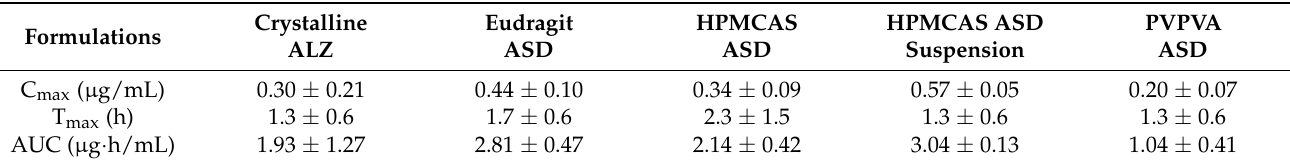
Table 4. PK parameters for oral administration study of ALZ ASDs in beagle dogs.